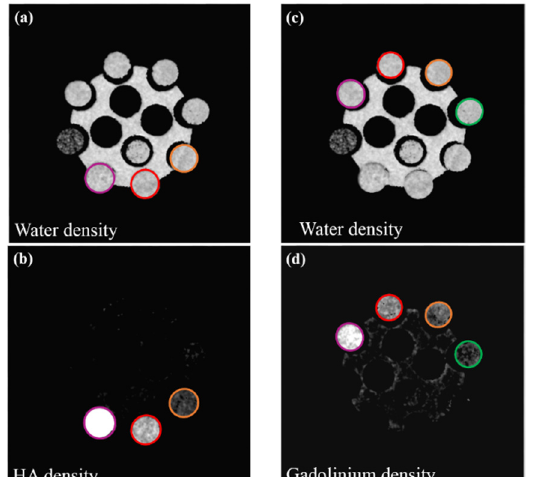
Figure 3. Selection of region of interest (ROI)s over each concentration in HA density ( b ) and gadolinium density images ( d ); and their comparison with the corresponding voxels in the water density images ( a , c ) using protocol-1. The percentage of successful voxels over each concentration provides the true positive rate whereas unsuccessful voxels provide the false negative rate.